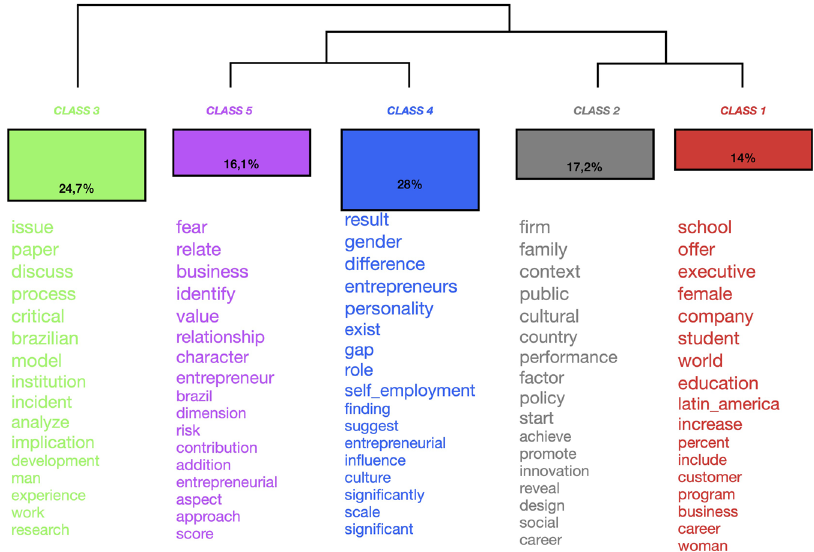
Fig. 5 Descending hierarchical classi fi cation of words in papers published in English.